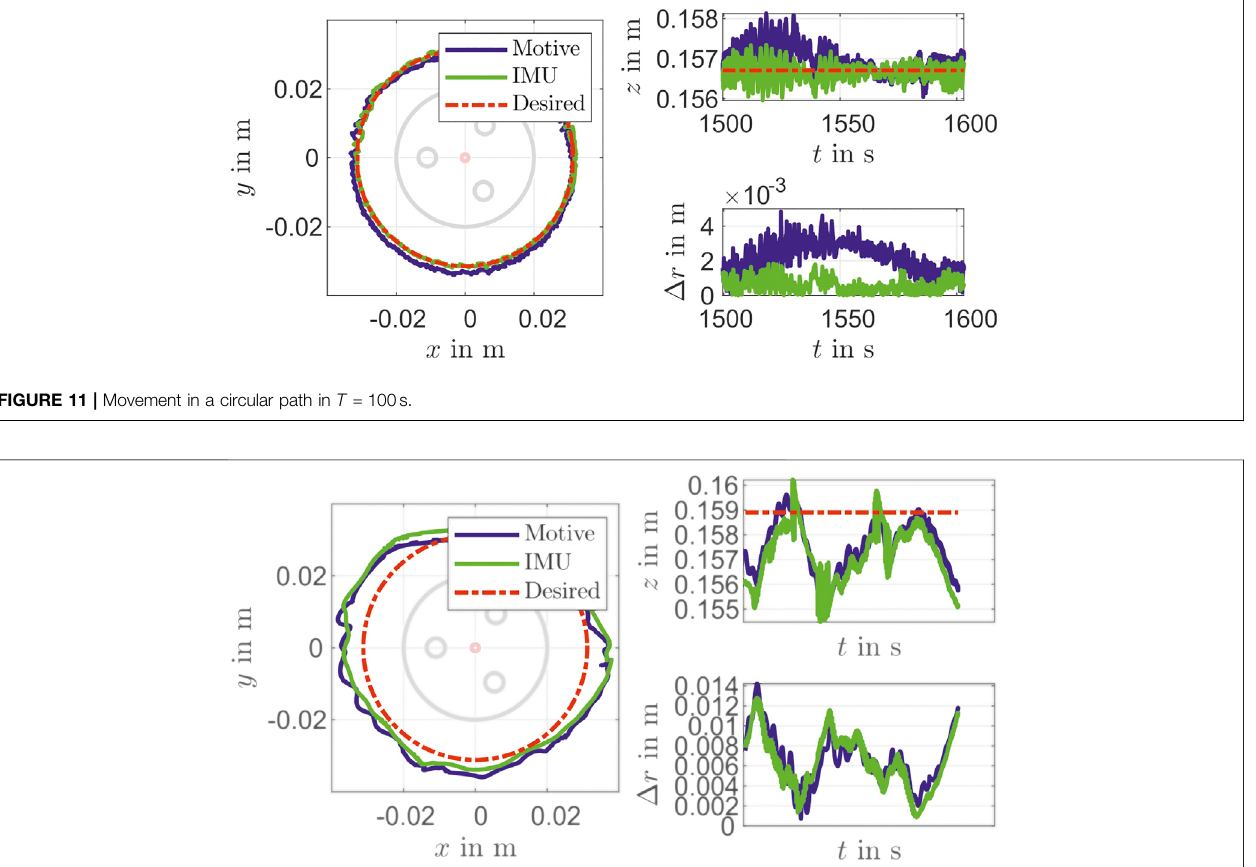
FIGURE 12 | Movement in a circular path in T (cid:1)